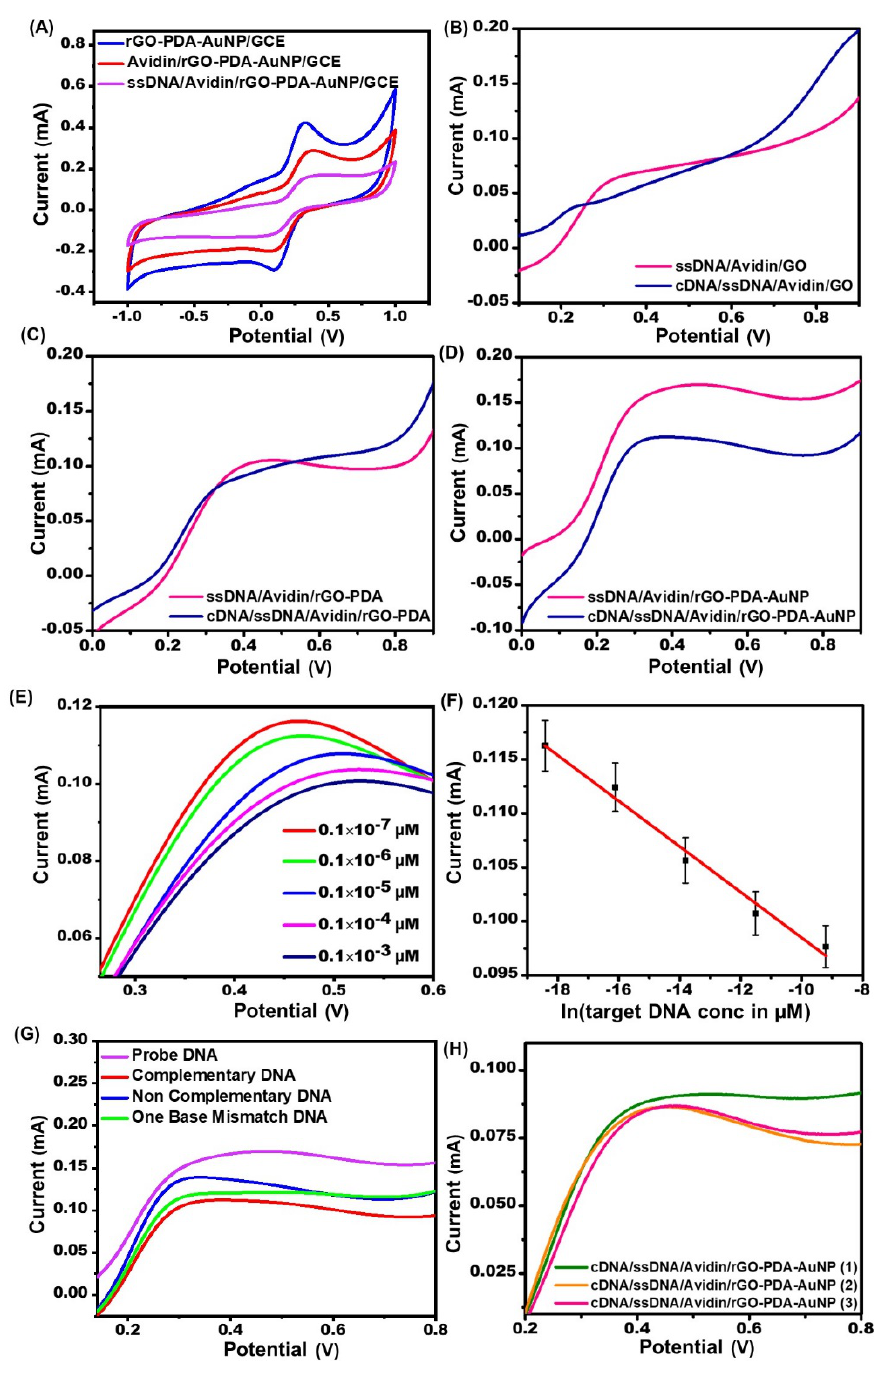
Figure 5. ( A ) CV comparing the electrochemical responses of rGO-PDA-AuNP/GCE, avidin- Figure 6. This is a figure. Schemes follow the same formatting. If there are multiple panels, they rGO-PDA-AuNP/GCE, and ssDNA-avidin-rGO-PDA-AuNP/GCE electrodes, sensing response should be listed as: ( a ) Description of what is contained in the first panel. ( b ) Description of what is of ( B ) ssDNA-avidin-GO, ( C ) ssDNA-avidin-rGO-PDA, and ( D ) ssDNA-avidin-rGO-PDA-AuNP bio- contained in the second panel. Figures should be placed in the main text near to the first time they electrodes for CDNA specific to MTB. ( E ) LSV showing variation in the electrochemical response of the are cited. A caption on a single line should be centered. ssDNA/avidin/rGO-PDA-AuNP/GCE bioelectrode after hybridization with various concentrations of CDNA from 0.1 × 10 − 7 to 0.1 × 10 − 3 µ M. ( F ) A linear plot of I p versus ln complementary/target Table 1. This is a table caption. Tables should be placed in the main text near to the first time they DNA. ( G ) LSV showing the variation in LSV responsiveness of the ssDNA/avidin/rGO-PDA- are cited. AuNP/GCE bioelectrode upon hybridizing with CDNA, noncomplementary DNA, and a one-base mismatch DNA sequence. ( H ) LSV plots revealing the reproducibility of the ssDNA/avidin/rGO- PDA-AuNP/GCE